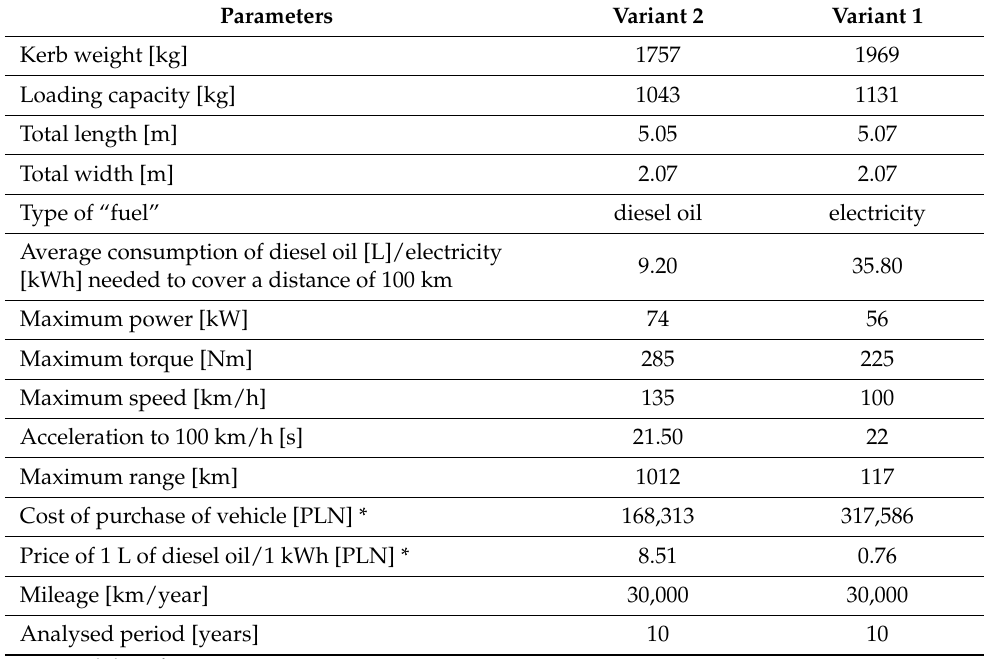
Table 3. Technical parameters and costs of the purchase of analysed vehicles